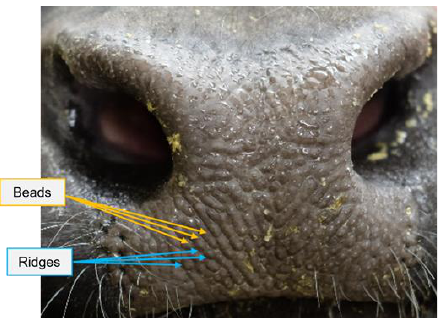
Figure 1. The illustration and terminologies of a beef cattle muzzle pattern.